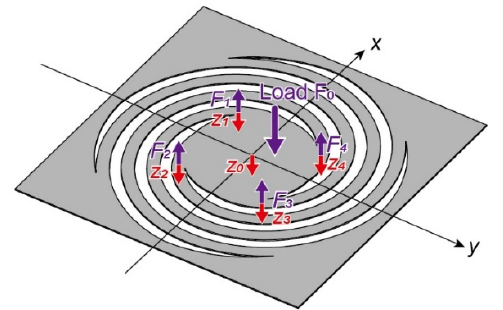
Figure 5. Relationship between the applied force and output displacement.